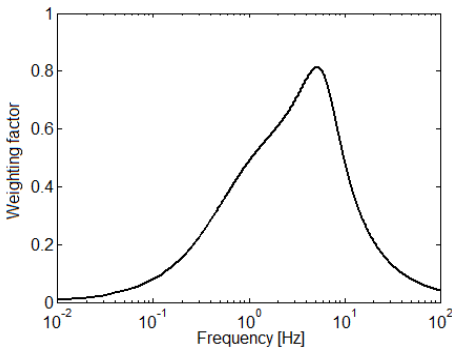
Figure 4. The frequency weighting function B .